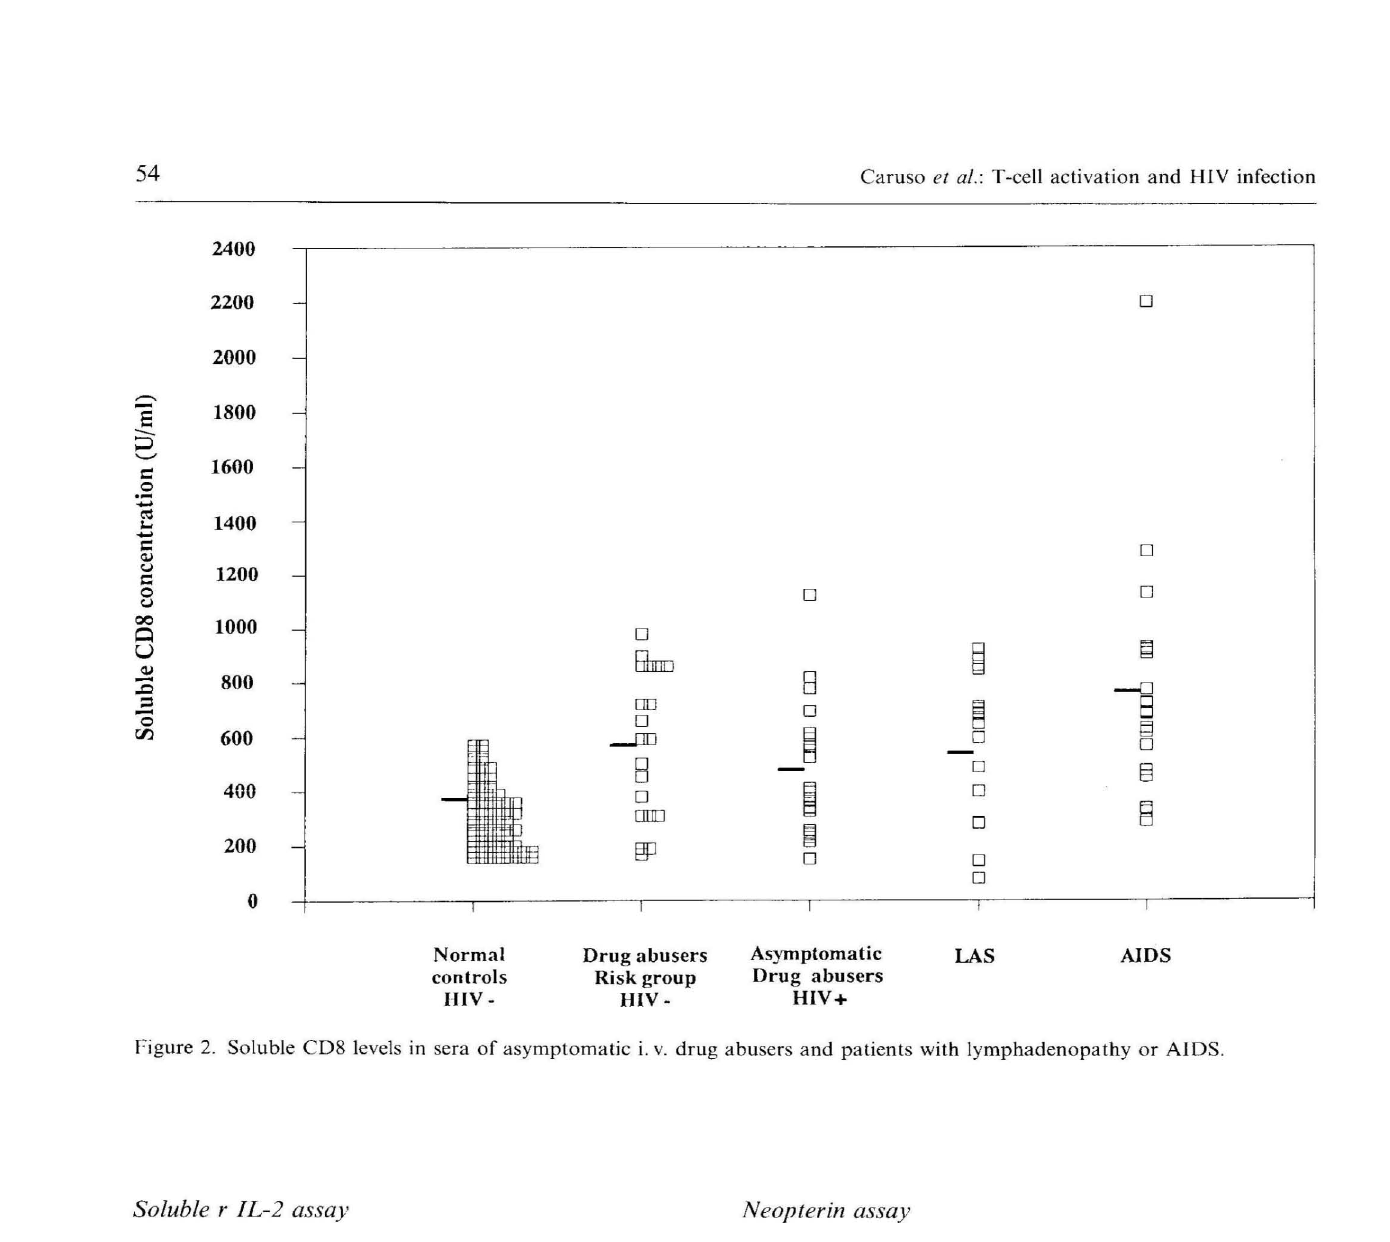
Figure 2. Soluble CD8 levels in sera of asymptomatic i. v. drug abusers and patients with lymphadenopathy or AIDS.